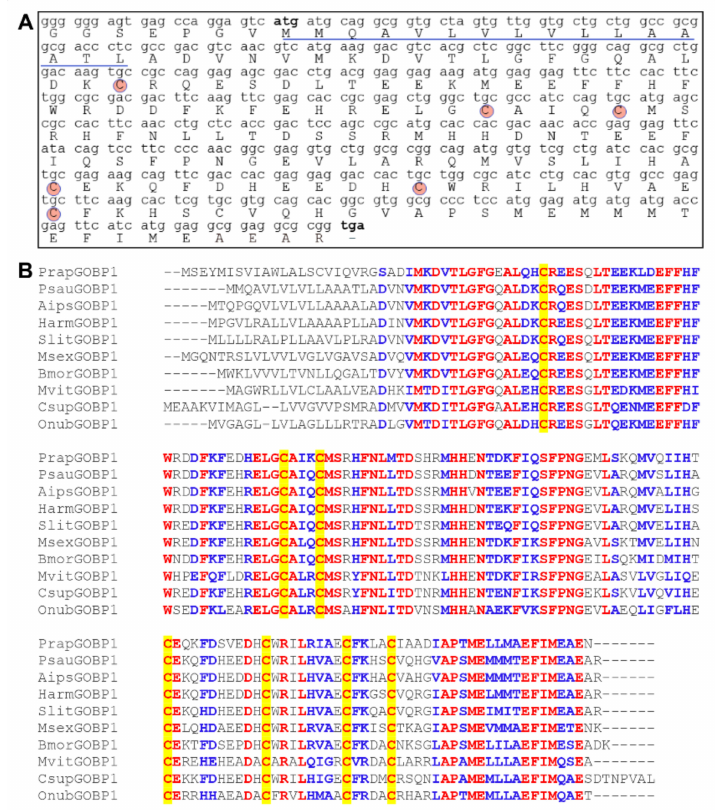
Figure 1. PsauGOBP1 sequence characterization and multiple alignment with other homologous proteins. ( A ) Nucleotide sequence and deduced amino acid sequence of the PsauGOBP1 cDNA. The six conserved cysteine residues are indicated in circles. The predicted signal peptide is underlined. The start and stop codons are marked in bold. ( B ) Alignment of GOBP1s of 10 Lepidoptera